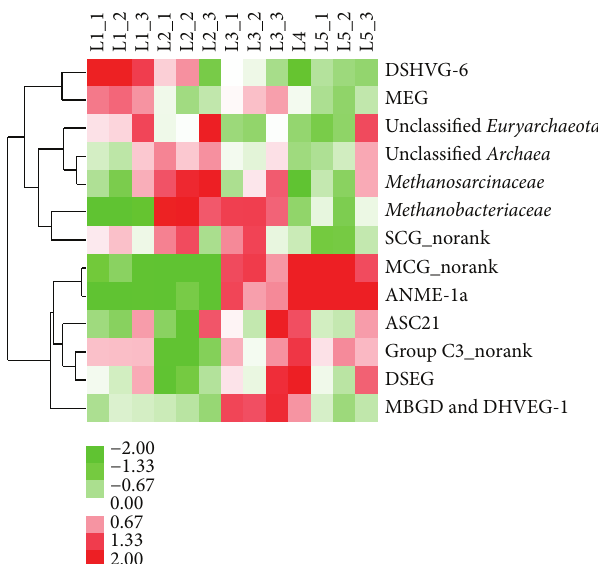
Figure 3: Clustering analysis of the most abundant 13 families versus different sediment layers (MCG: Miscellaneous Crenar- chaeotic Group; DHVEG-6: Deep Sea Hydrothermal Vent Gp- 6; MEG: Miscellaneous Euryarchaeotic Group; DSEG: Deep Sea Euryarchaeotic Group; MBGD: Marine Benthic Group D; ANME: anaerobic